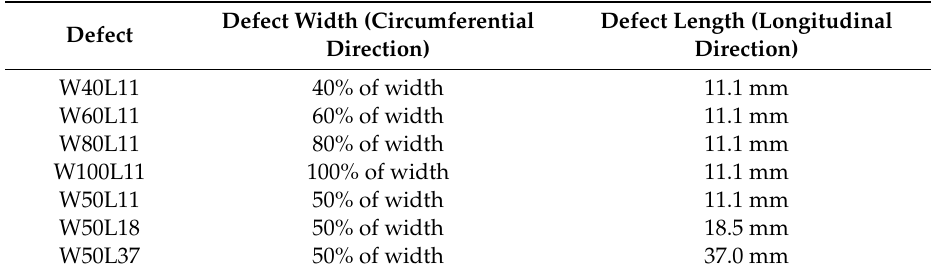
Figure 1. A schematic to define the projected width of the sheep radius and the defect depth, which is directly dependent on the defect width. For the smaller defects, the width is defined as the cortical thickness, while for the wider defects, the thickness is defined as radius in the short axis. Table 1. Di ff erent cortical window sizes to test the e ff ect of defect size on the stress distribution. The width of the radius is defined as projection width of the diaphysis as indicated in Figure